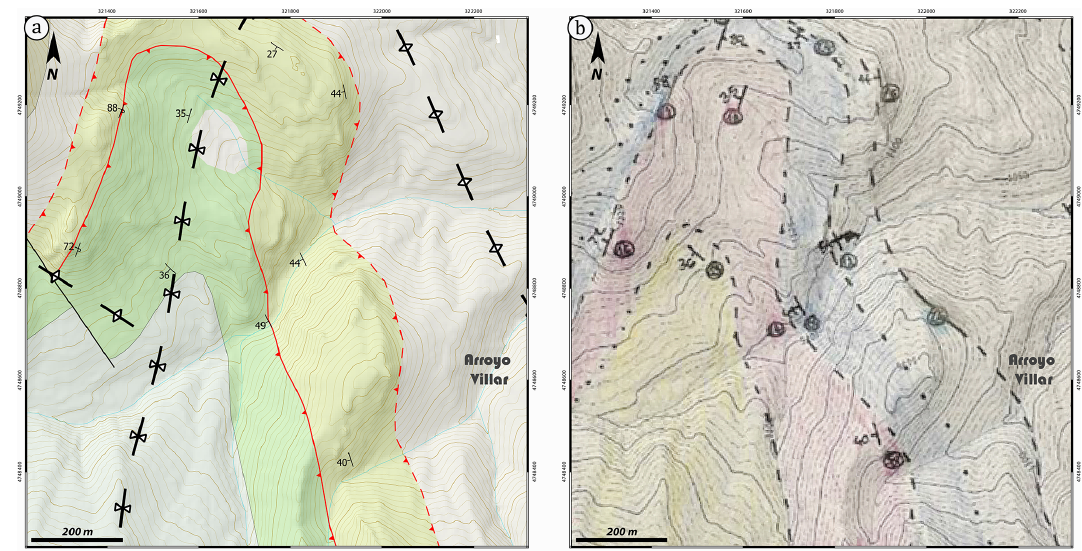
Figure 6. Detail of the geological map of the Esla Nappe immediately west from the locality of La Velilla de Valdoré (see Fig. 1b for the location). (a) Modified version of the continuous digital geological map of Spain (GEODE) from the Spanish Geological Survey (modified from Merino-Tomé et al., 2014). Bedding data are the same as those provided to the students in the Esla Mapping Project. (b) Geological map produced by one of the students as a result of the Esla Mapping Project. Note that the cross section shown in Fig. 3b was not drawn through the syncline shown in this map but through the more eastern Pardominos Anticline (axial trace shown on the NE corner of a ).